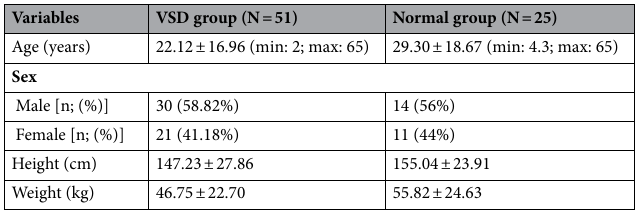
Table 1. Basic information of the subjects in this study.